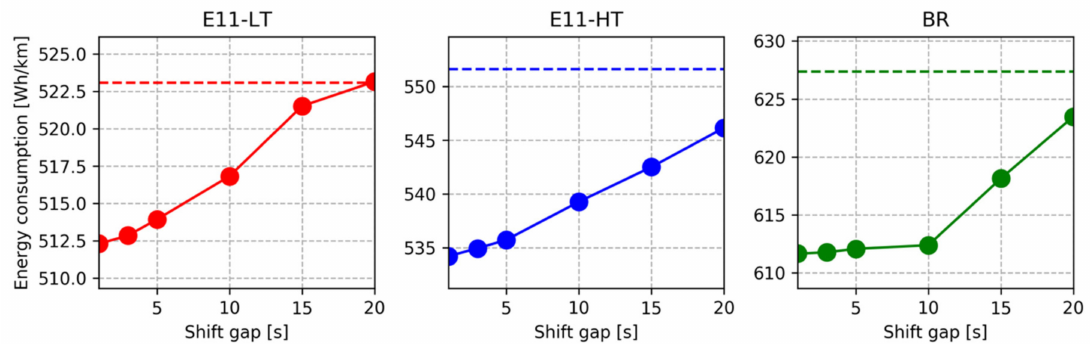
Figure 10. Energy consumption as a function of the minimum shift gap parameter value. The dashed horizontal lines represent the reference consumptions.